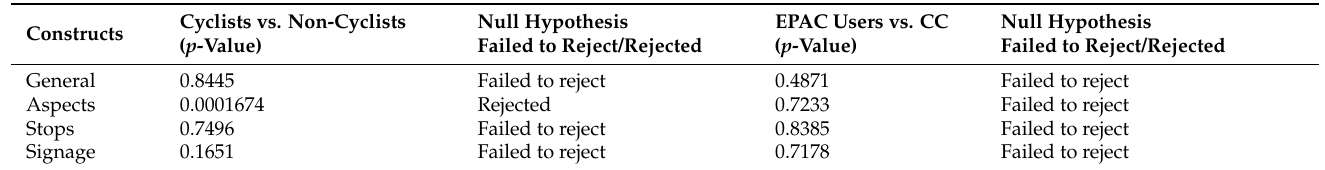
Table 4. Hypothesis testing on construct level.